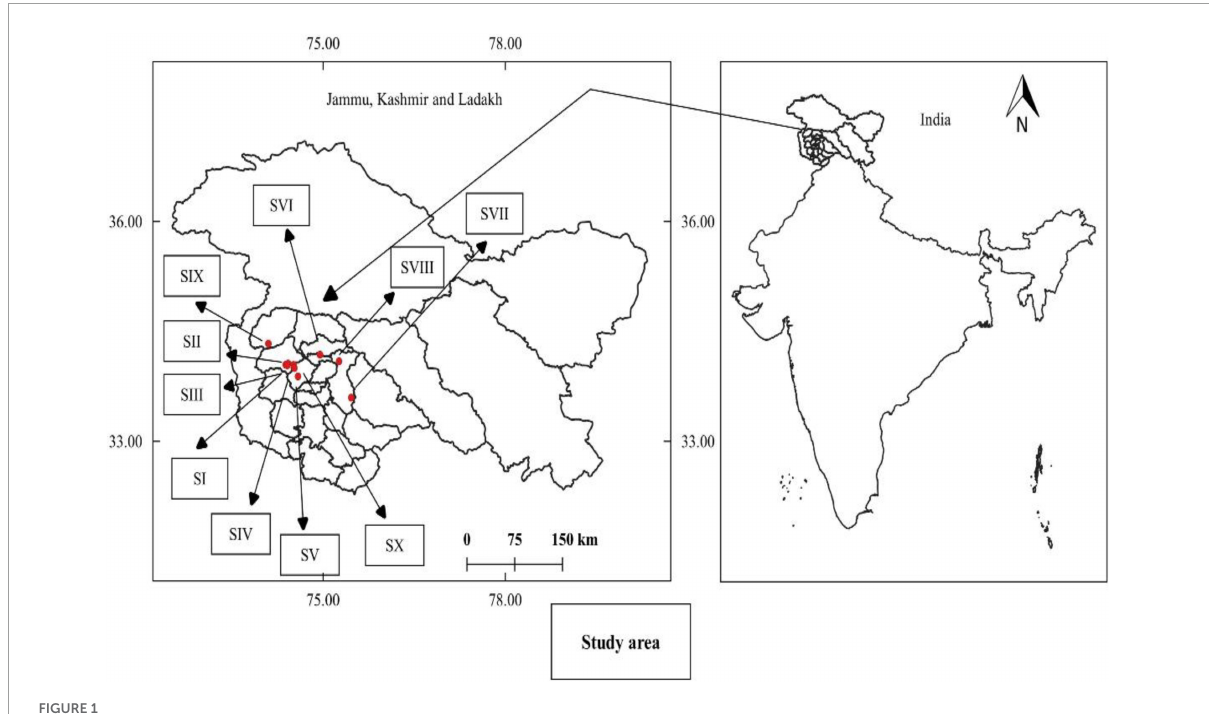
FIGURE1 Map showing the study area and sampling sites in Kashmir Himalaya, India. (SI–Tangmarg; SII–Gulmarg; SIII–Drung; SIV–Gogaldara; SV–Doodhpathri; SVI–Dara Harwan; SVII–Daksum; SVIII–Pahalgam; SIX–Bangus; SX–Khag).